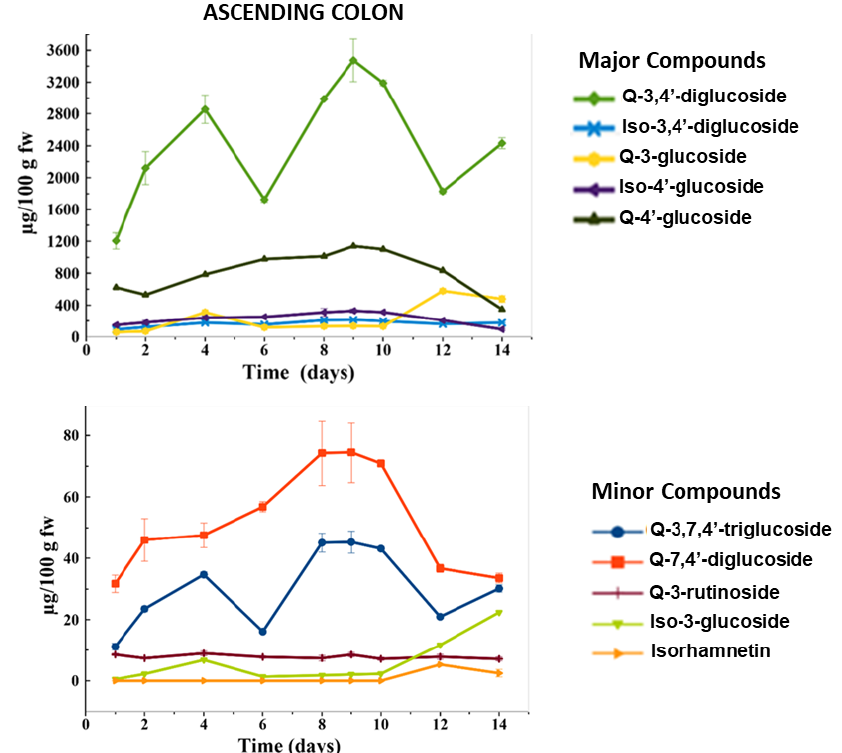
Figure 1. Concentration (µg/100 g fw of slurry) of flavonols in the ascending colon (AC) during the colonic fermentation of HPP-treated onion. Data are the mean value ± standard deviation of the three different determinations ( n = 3).